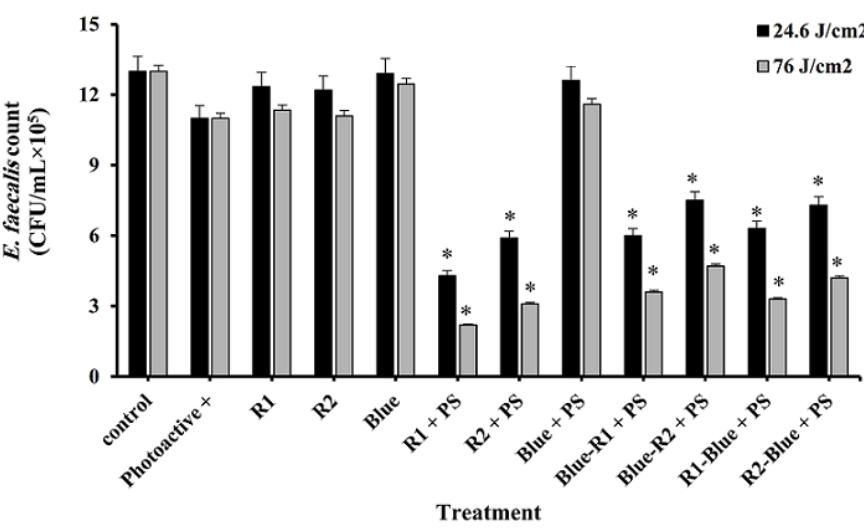
Figure 1. E ff ect of light sources on photoactive + -mediated aPDT on E. faecalis (CFU / mL). R1: λ = 635 nm, R2: λ = 660 nm, blue: λ = 420–480 nm, * p < 0.05; significantly di ff erent from the control.